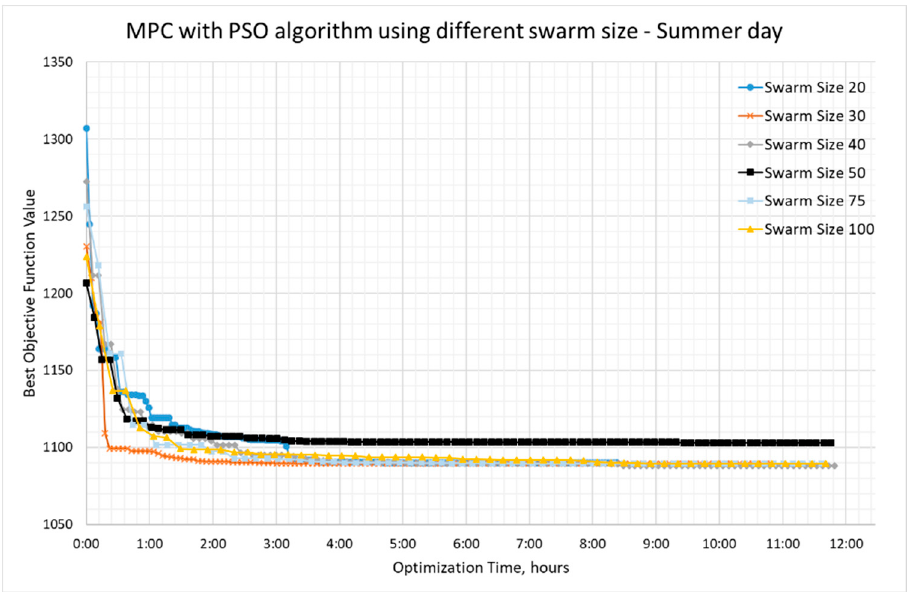
Figure 8. PSO optimization results on the spring day with different swarm size.